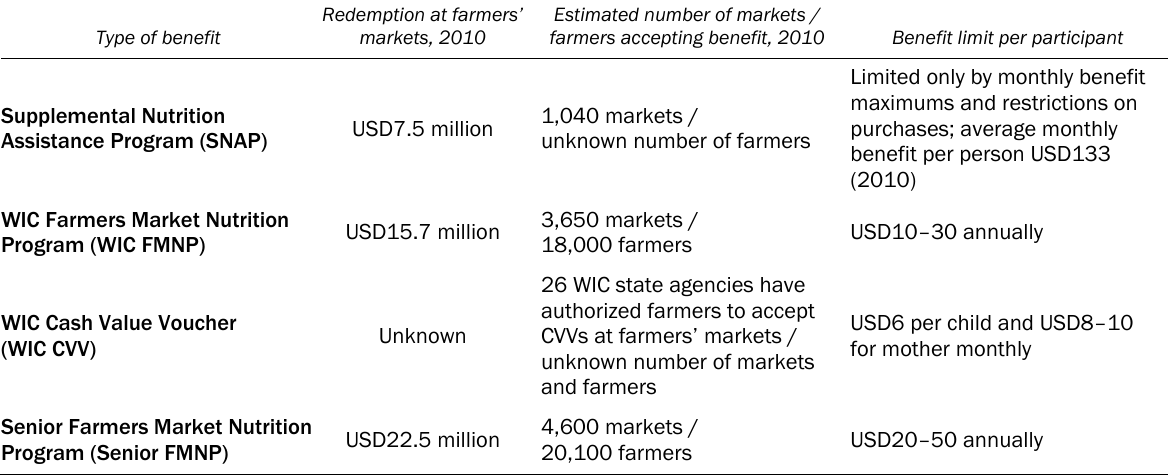
Table 1. Types of Federal Nutrition Benefits and Usage at Farmers’